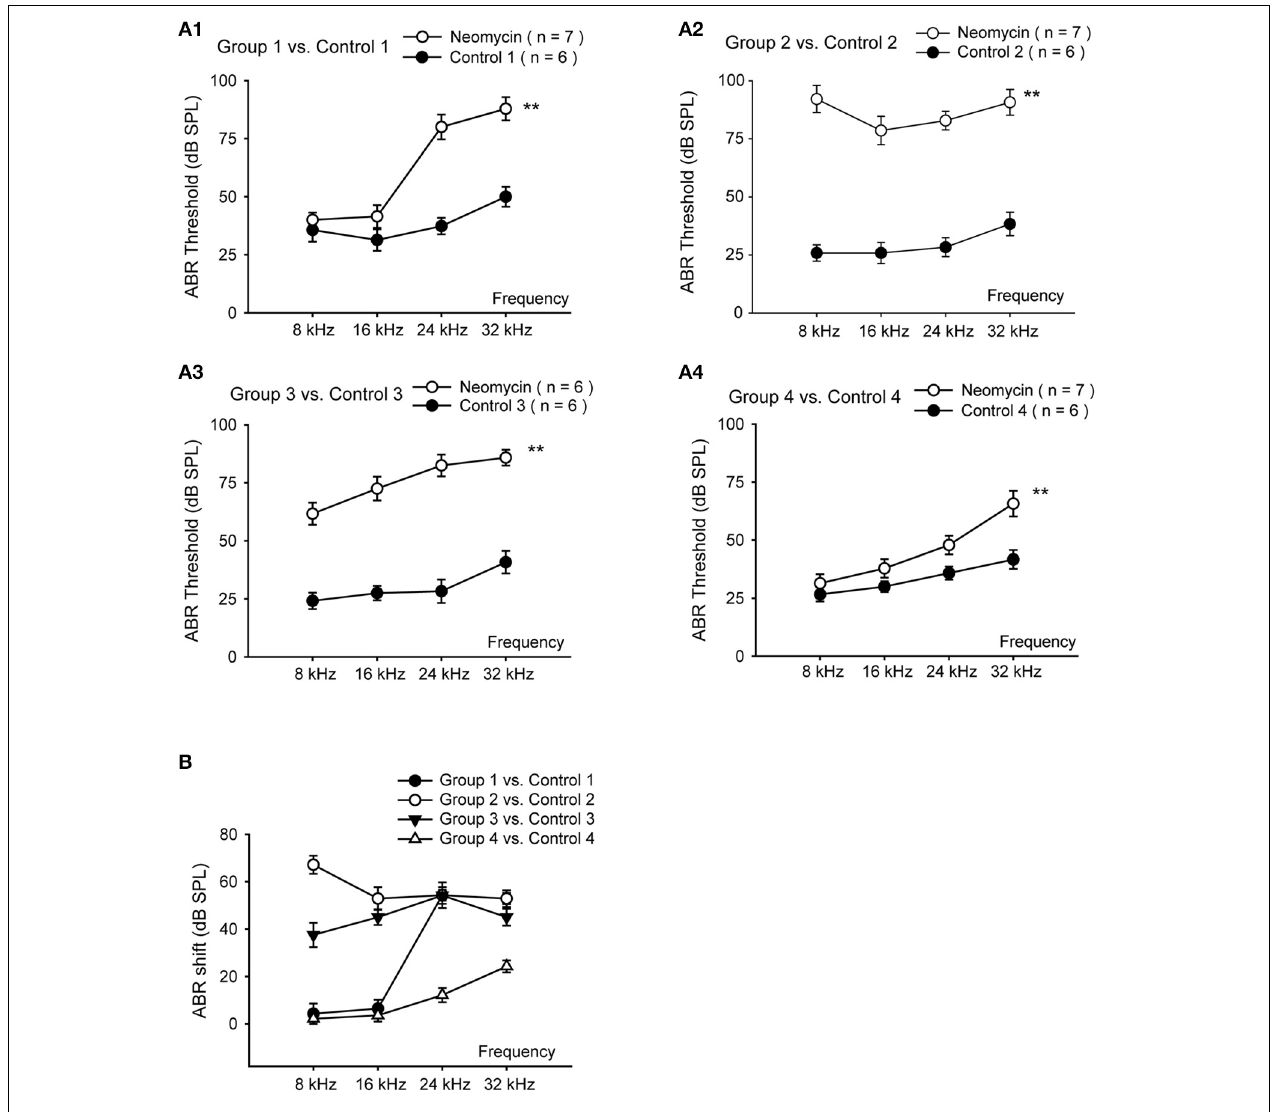
FIGURE 1 | Hearing loss in neomycin-treated WT mice. (A) ABR measurements of WT mice 2 weeks after the last injection of neomycin or saline (control). Neomycin or saline was injected once daily between P1 and